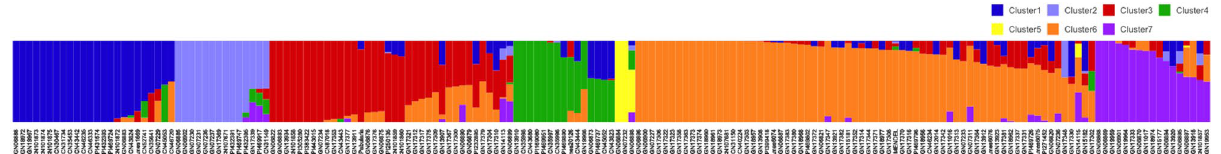
Figure 2. Population structure analysis of 177 accessions of Brassica napus based on model-based Bayesian clustering using STRU CTU RE for K = 7